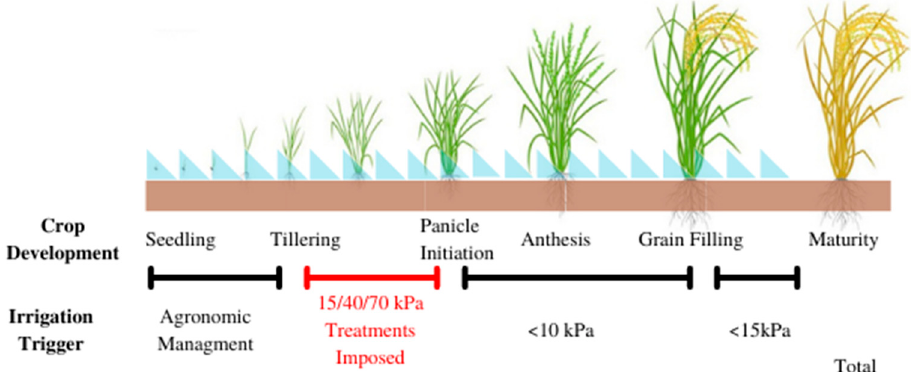
Figure 3. Irrigation management at the different crop growth stages.